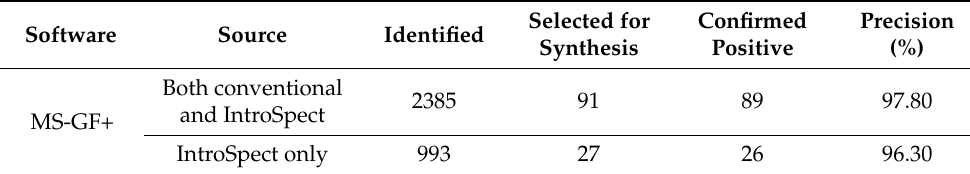
Selected for Confirmed Precision Synthesis Positive (%) 2385 91